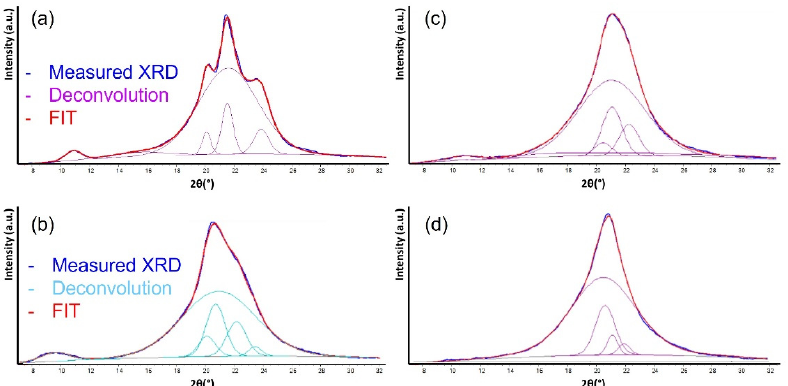
Figure 6. XRD spectra with deconvolution of the different crystalline and amorphous phases for PA6 ( a ), PA6.9 ( b ), PA 6.9-6 80-20 ( c ), PA6.9-6 60-40 ( d ). The measured crystallinity, considered as the ratio of the crystalline phases with respect to the whole area (given by the sum of amorphous and crystalline phases) is 32% for PA6, 31% for PA6.9, 24% for PA6.9-6 80-20 and 22% for PA6.9-6 60-40. As expected,